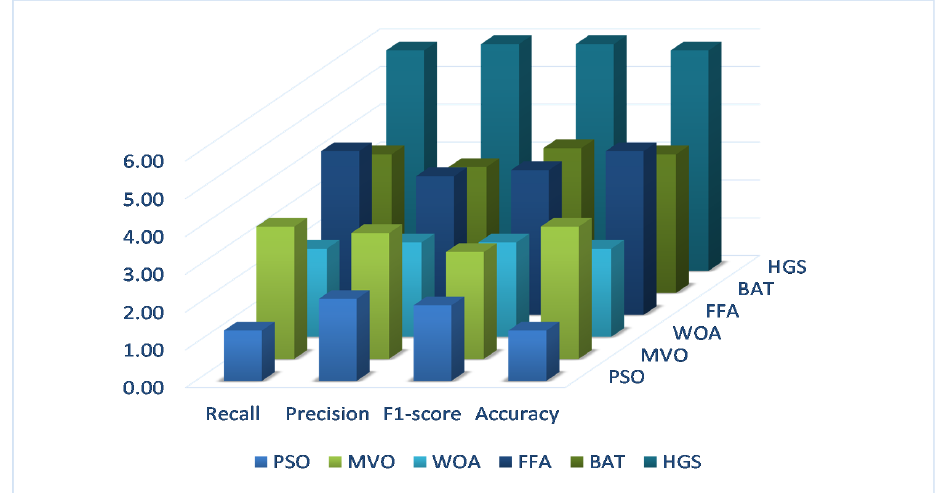
Figure 6. The mean rank of FD test to compare among FS optimization